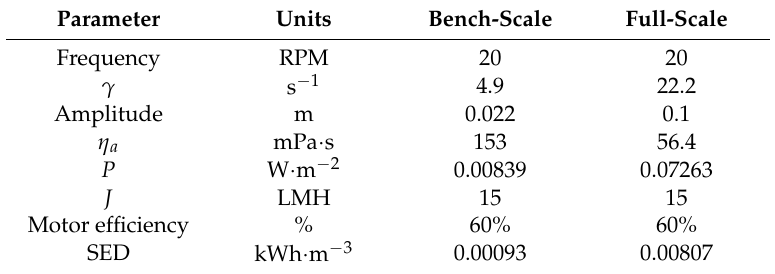
Table 2. Calculated parameter values, according to the approach of Buzatu et al.